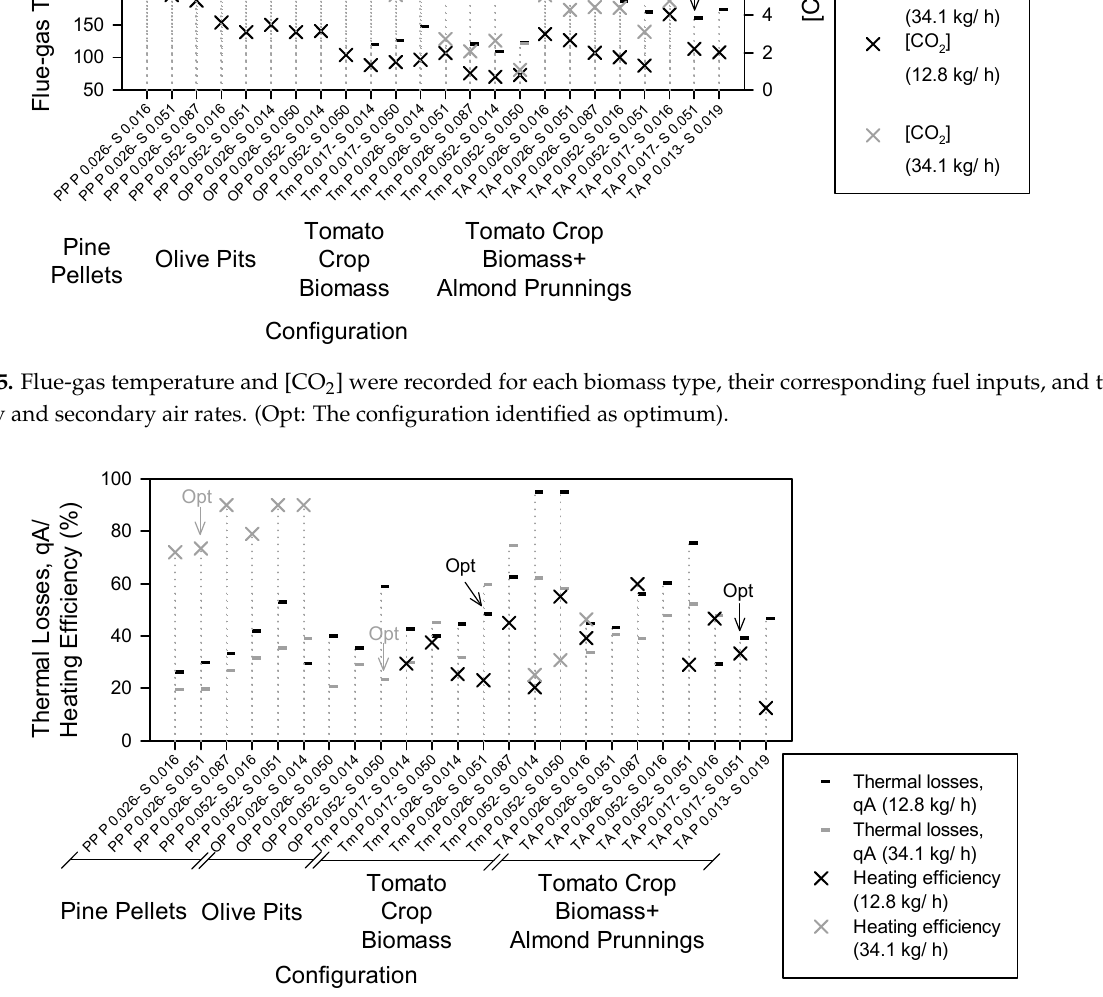
Figure 6. The thermal losses and heating efficiency recorded for each biomass type, their corresponding fuel inputs, and the primary and secondary air rates, together with the corresponding heating efficiency (Opt: Configuration identified as optimum; * Value surpassing 90%,